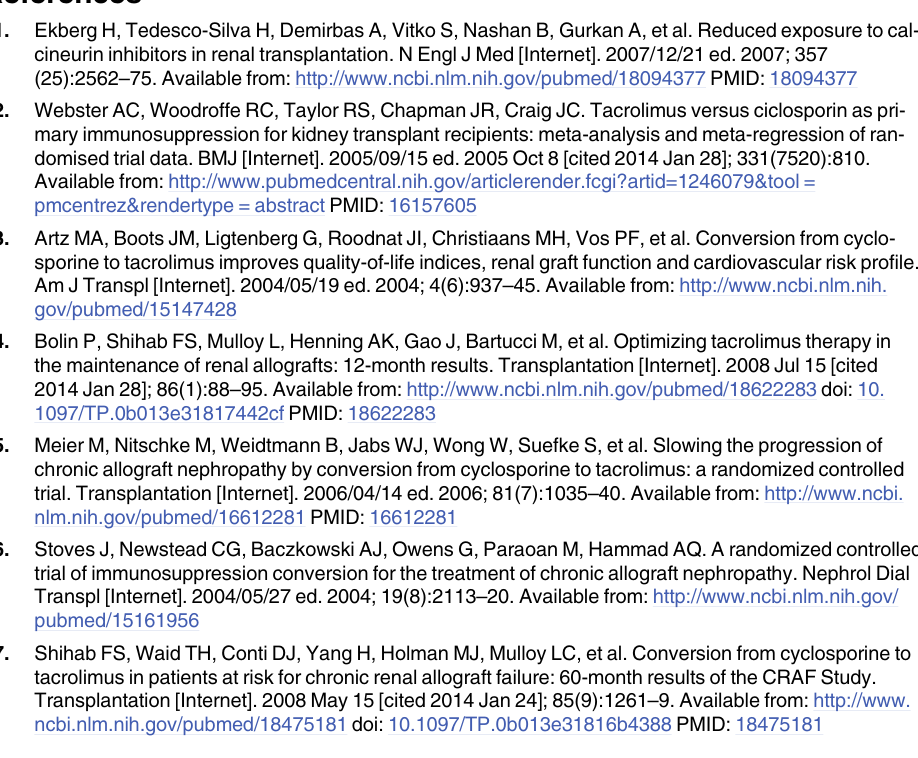
S1 Table. Multivariable Data Analysis Results. Additional information about the two models from Table